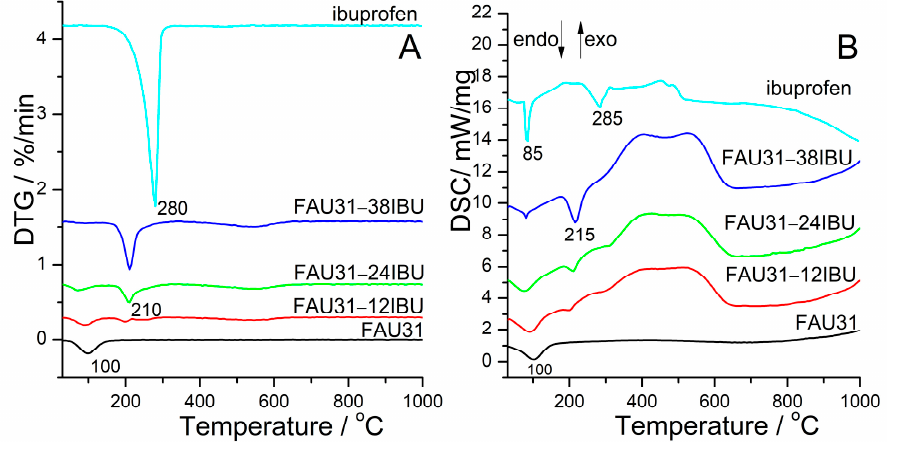
Figure 2. DTG ( A ) and DSC ( B ) curves of the samples under study.